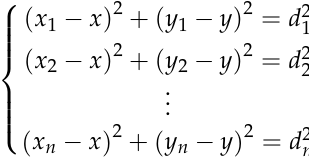
Figure 10. The positioning processing time changes with different cluster number.